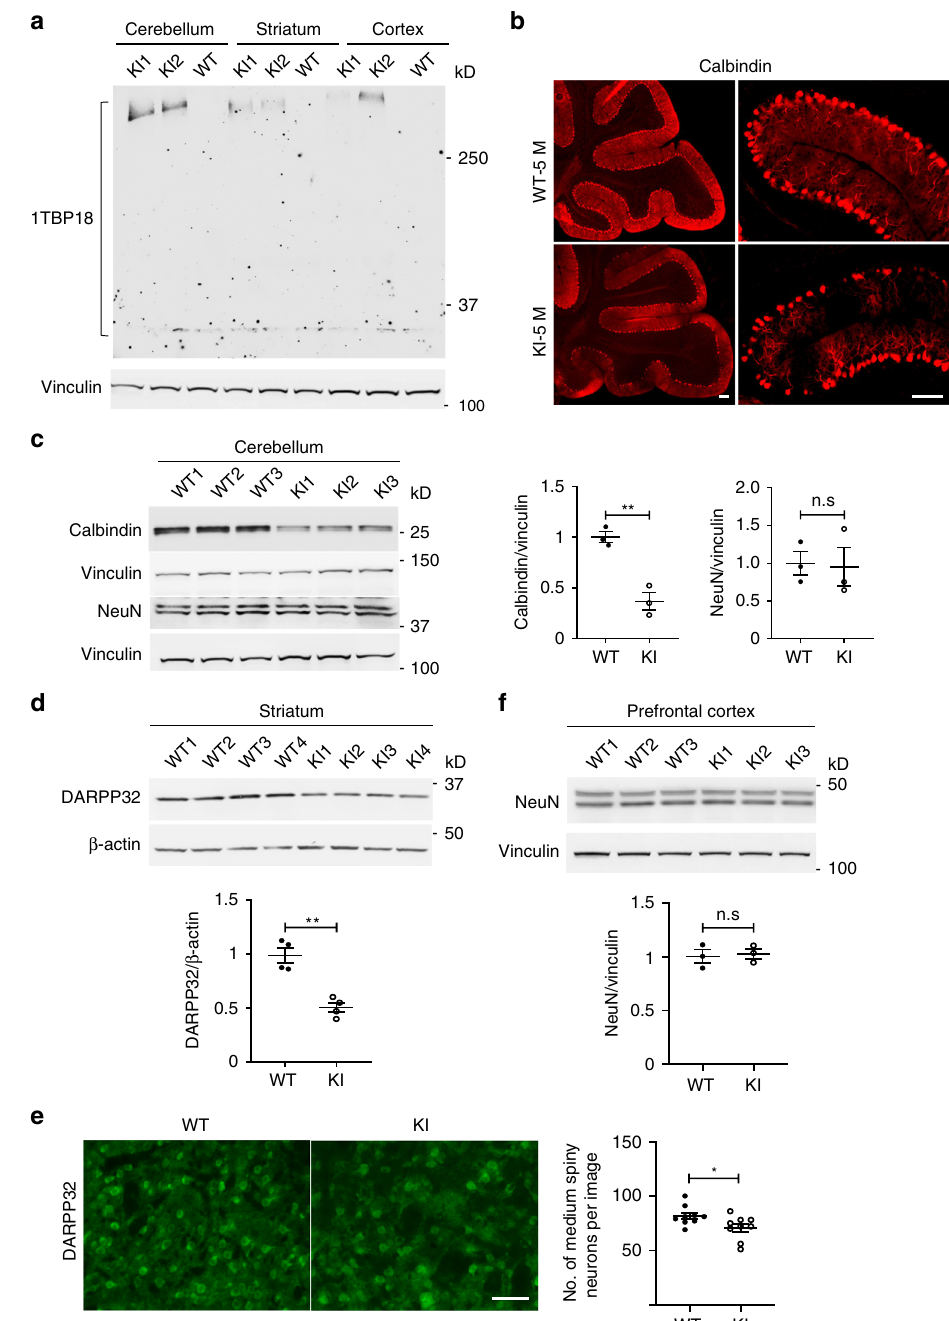
Fig. 3 Selective neuronal loss is also caused by endogenously expressed mutant TBP. a Western blotting analysis of TBP expression in the cerebellum, striatum, and prefrontal cortex from 3-month-old SCA17 knock-in (KI) and wild-type (WT) mice. Vinculin was used as a loading control. b Immuno fl uorescent staining of Purkinje neurons with anti-calbindin antibody in the cerebellum of 5-month-old WT and KI mice. Scale bar = 100 μ m. c Western blotting analysis of calbindin and NeuN levels in the cerebellum of 5-month-old WT and KI mice. The densitometric ratios of calbindin to vinculin and NeuN to vinculin were normalized to WT and analyzed with Student ’ s t test, t = 6.305, ** P = 0.0032, n = 3 mice per group. d Western blotting of DARPP32 levels in the striatum of 5-month-old WT and KI mice. β -Actin was used as a loading control. The densitometric ratios of DARPP32 to β -actin were normalized to WT and analyzed with Student ’ s t test, t = 5.872, ** P = 0.0011, n = 4 mice per group. e Immuno fl uorescent staining with anti- DARPP32 antibody in the striatum of 5-month-old WT and KI mice. Scale bar = 50 μ m. Quantitative assessment of the number of medium spiny neurons labeled by DARPP32 per image fi eld are also presented, t = 2.301, * P = 0.0352, n = 3 mice per group, three images from each mouse were used to count. f Western blotting of NeuN levels in the prefrontal cortex of 5-month-old WT and KI mice. The densitometric ratios of NeuN to vinculin were normalized to WT and analyzed with Student ’ s t test. n = 3 mice per group. Data are represented as mean ± SEM. Source data and full blots are provided as a Source Data fi